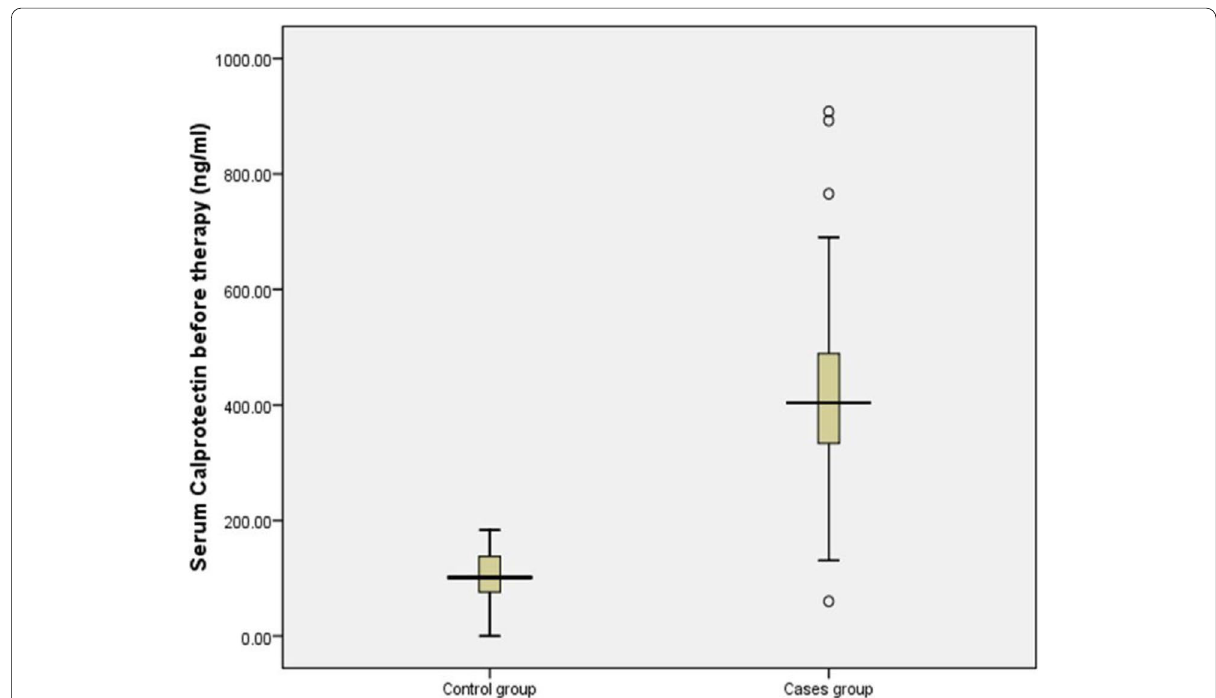
Fig. 1 Box and Whisker plot of baseline serum calprotectin concentrations among the study cohort. Rheumatoid arthritis patients showed remarkably higher levels [404.1 (60.0–908.2 ng/ml)] as compared to the healthy controls [101.45 (0.0–183.7 ng/ml)]; P < 0.001